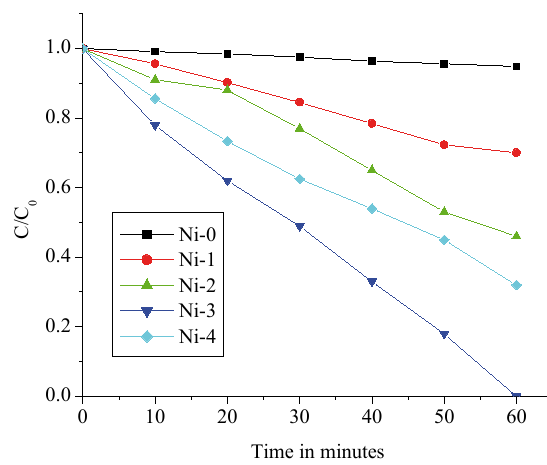
Figure 6. Plot of C/C0 versus time for the degradation of MO using various photocatalysts under solar versus 0